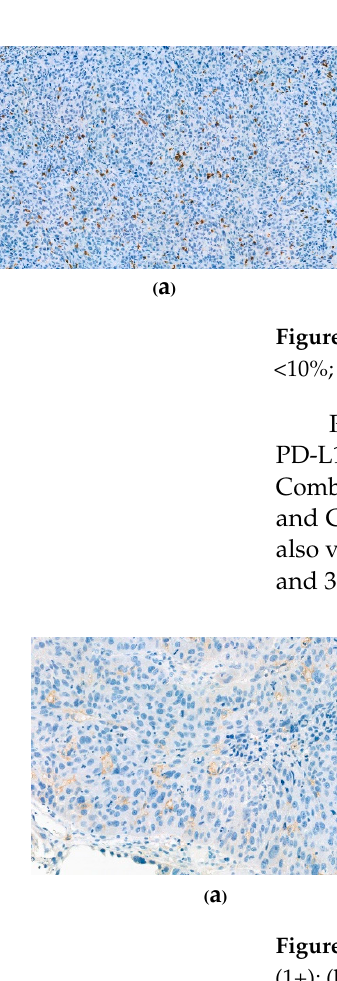
Figure 3 . Immunohistochemical staining for PD - L1 ( 200× ). ( a ) CPS > 1 but < 20 with weak intensity ( 1 +) ; Figure 3. Immunohistochemical staining for PD-L1 (200 × ). ( a ) CPS ≥ 1 but < 20 with weak intensity ( b ) CPS > 20 with moderate intensity ( 2 +) ; ( c ) CPS > 20 with strong intensity ( 3 +). (1+); ( b ) CPS ≥ 20 with moderate intensity (2+); ( c ) CPS ≥ 20 with strong intensity